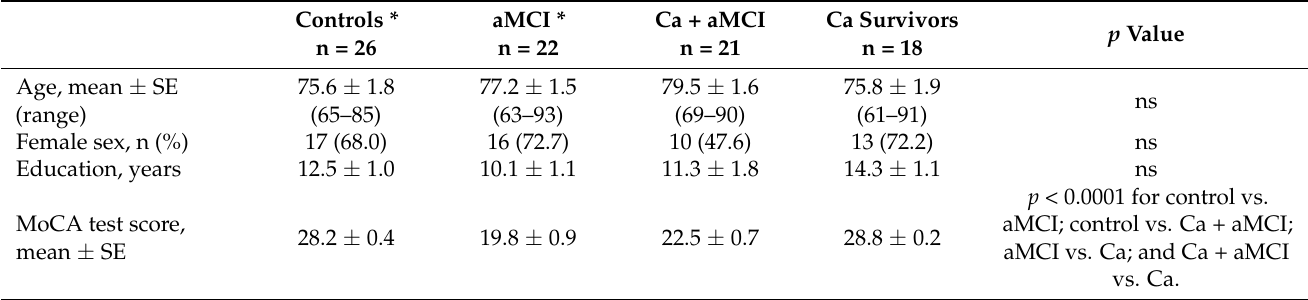
Table 1. Demographic data of participants.